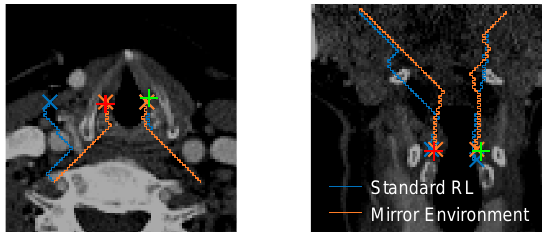
Figure 5. Agent-trajectories for localizing the vocal folds in two CT volumes (( left ): axial view, ( right ): coronal view). Localization failure ( left ) or higher localization error ( right ) for one fold despite correct localization of the other fold by the standard RL. The mirror environment showed improvement by employing similar policies for both. Red and green plus (+) signs indicate the expert-annotated RVF and LVF locations, respectively. The cross ( × ) signs indicate the agent-positions at the end of different trajectories.